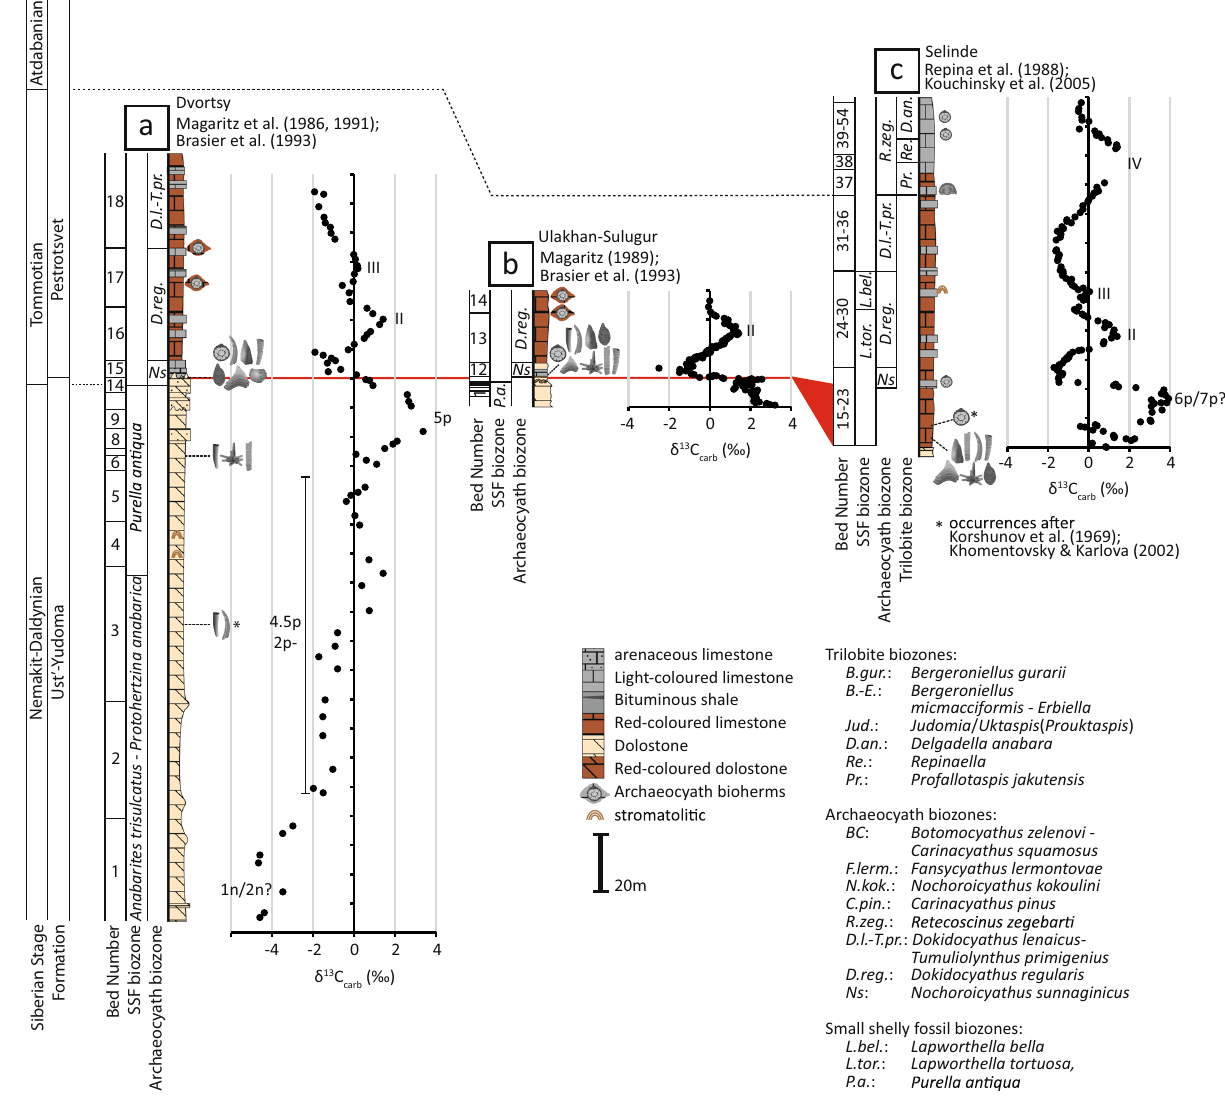
Fig. 2 | Lithostratigraphy, biostratigraphy and carbon isotope ( δ 13 C) data for sections of the Aldan and Selinde rivers bearing the earlierst archaeocyath reef communities of the Siberian Platform. a Dvortsy 27,28,30 b Ulakhan-Sulugur 33,34 , and c Selinde 69,70